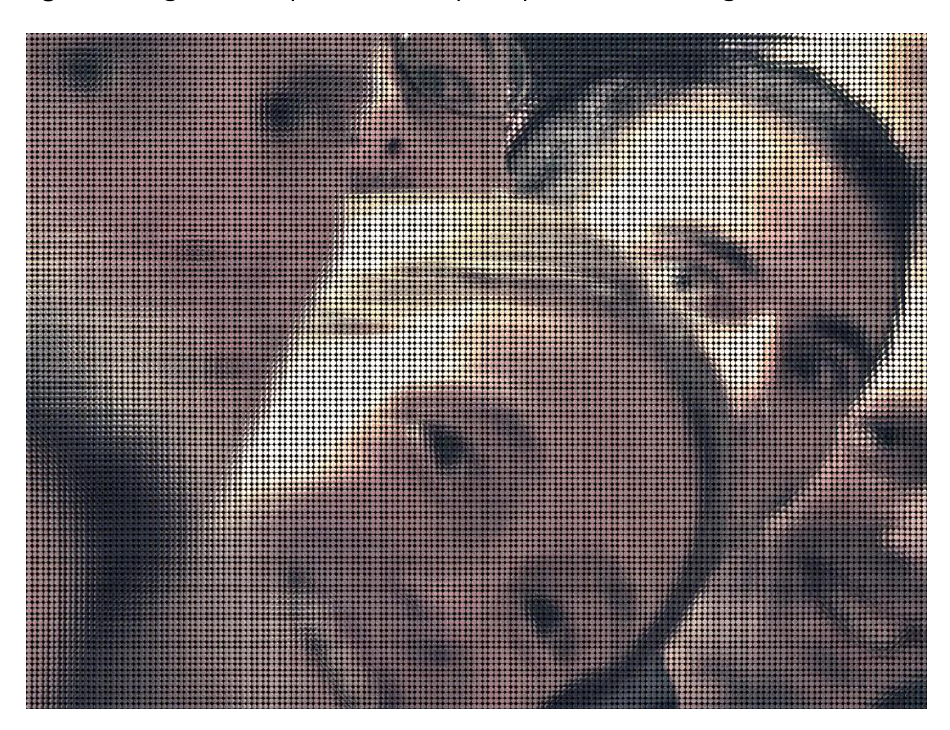
Figure 10. (a) Single image. (b) Depth